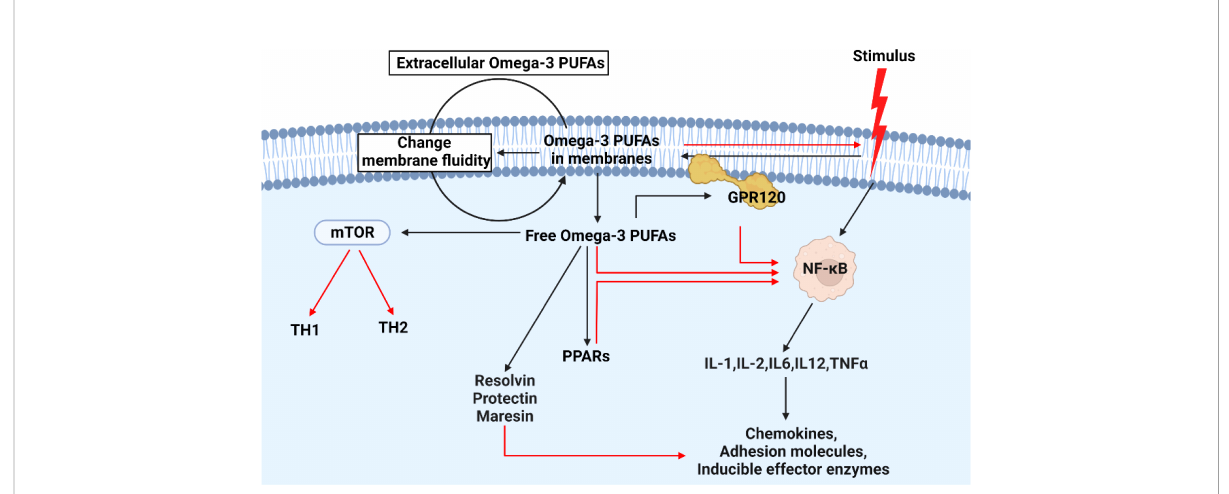
FIGURE 2 The mechanism of action of n-3 in cells when subjected to external in fl ammatory stimuli. When cells encounter external in fl ammatory stimuli, n-3 PUFAs will be activated. On the one hand, more extracellular n-3 PUFAs enter the cell by changing the fl uidity of the cell membrane. On the other hand, free intracellular n-3 PUFAs inhibit the expression of intracellular in fl ammatory factors by combing with other factors. Among them, GPR120: free fatty acid receptor 4 (FFA4). In the fi gure, the red line indicates the inhibitory